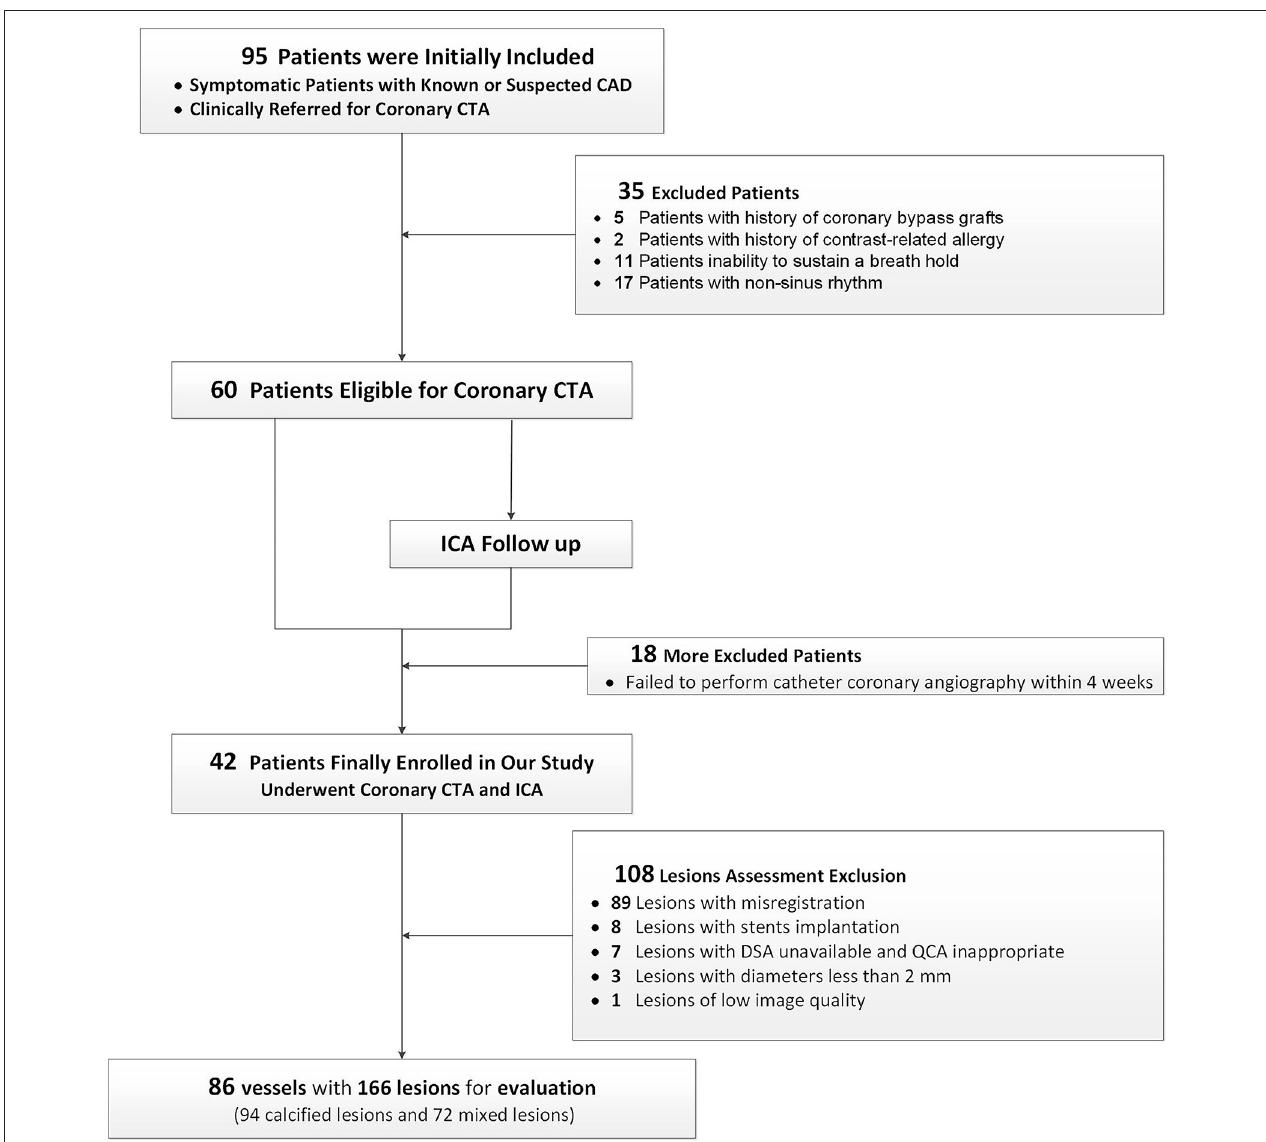
FIGURE 1 | A flow chart. A flow chart of subject enrollment and study design. Based on the predefined inclusion and exclusion criteria, 42 patients successfully underwent CCTA and ICA. CAD, coronary artery disease; CCTA, coronary CT angiography; ICA, invasive coronary angiography.